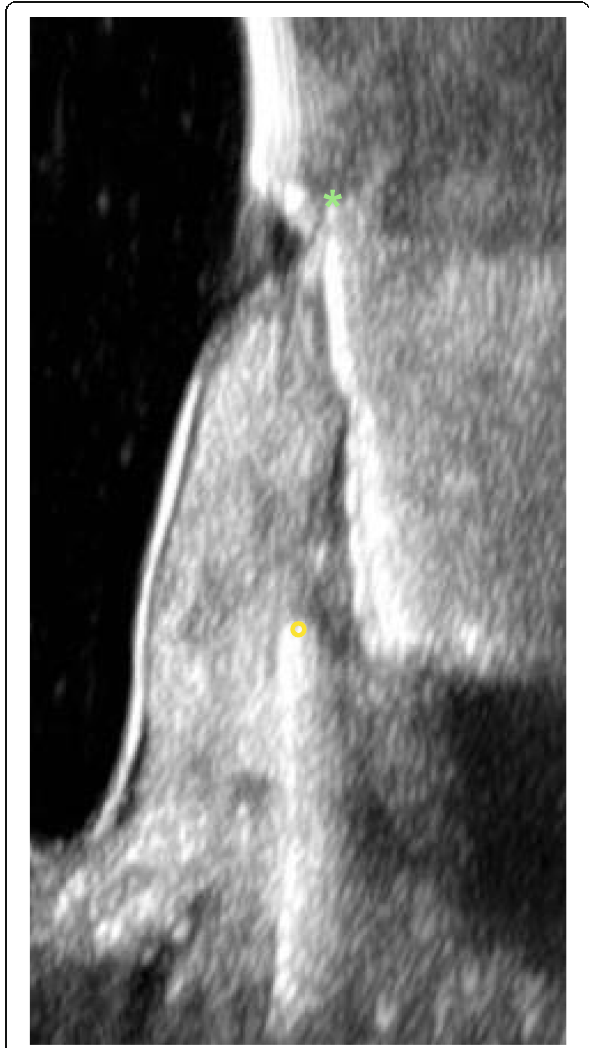
Fig. 14 Ultrasonic imaging at the implant in region 43 revealed a buccal bone loss up to the 5th thread with an infracrestal bone loss (asterisk marks the implant-abutment interface; circle marks the